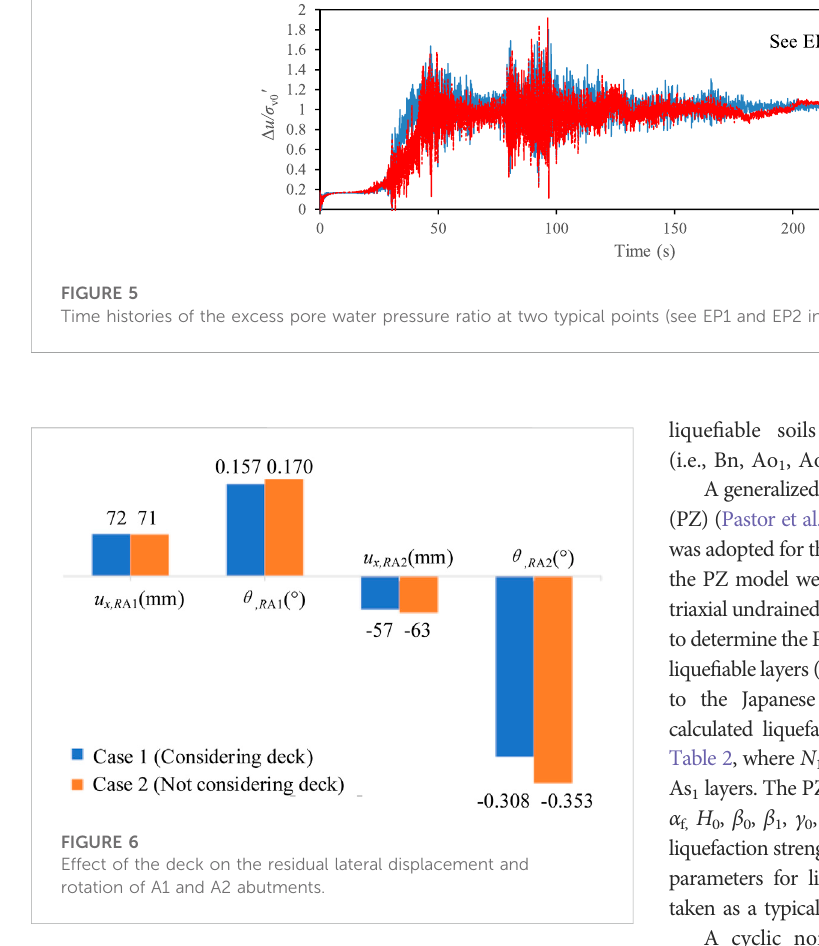
were used to determine the liquefaction potential of each layer according to the Japanese Design Speci fi cations of Highway Bridges (Japan Road Association, 2004; Towhata, 2008). Accordingly,